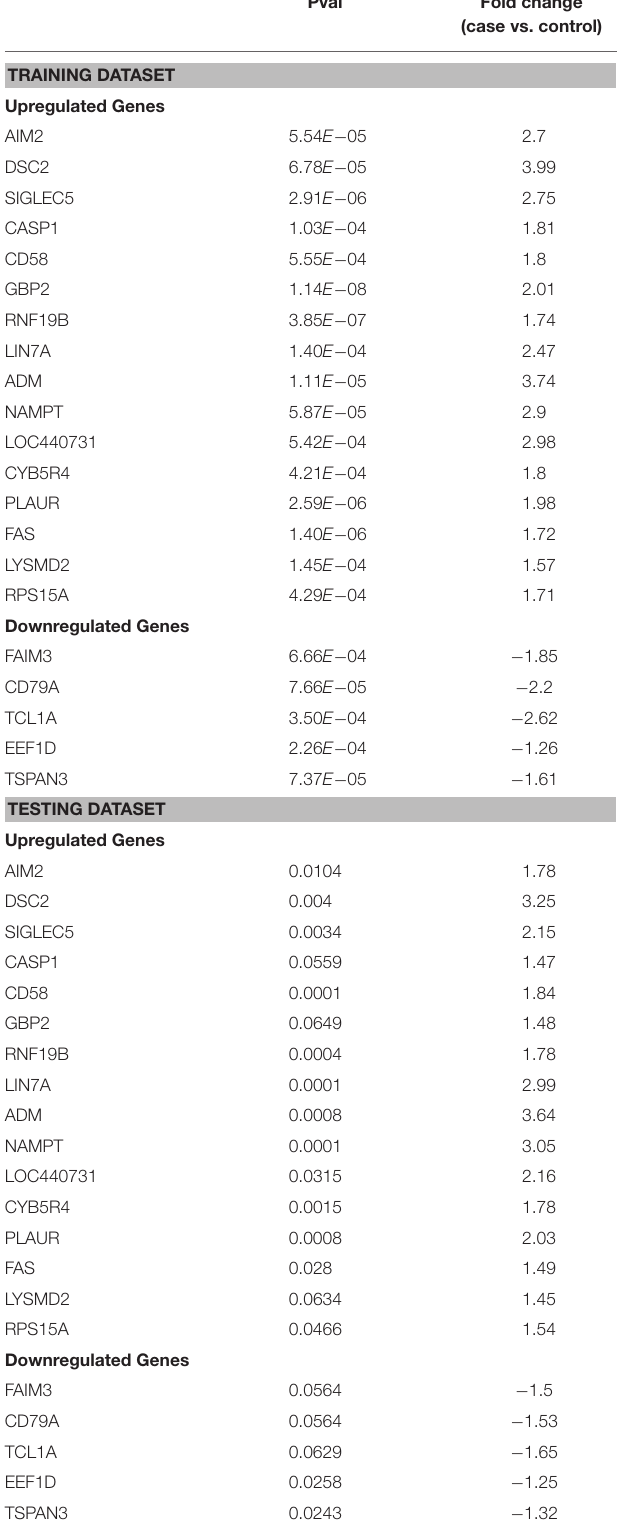
TABLE 3 | Differential expression of 21 genes transcripts detected in blood using nCounter expression assay (NanoString Technologies) in training and testing